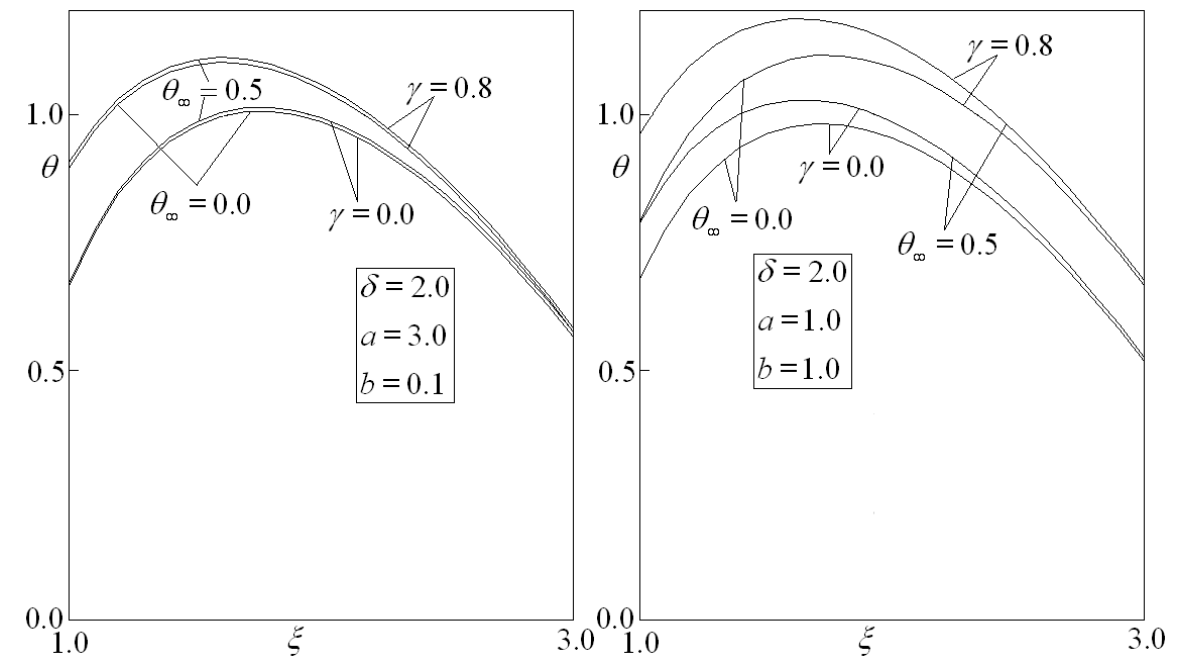
Figure 4. The dimensionless temperature θ as a function of the dimensionless position ξ for δ = 2.0.